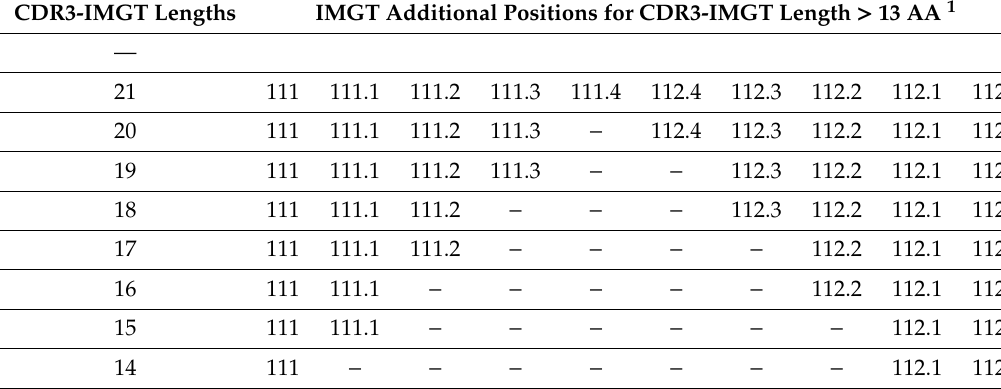
Table 11. IMGT additional positions for